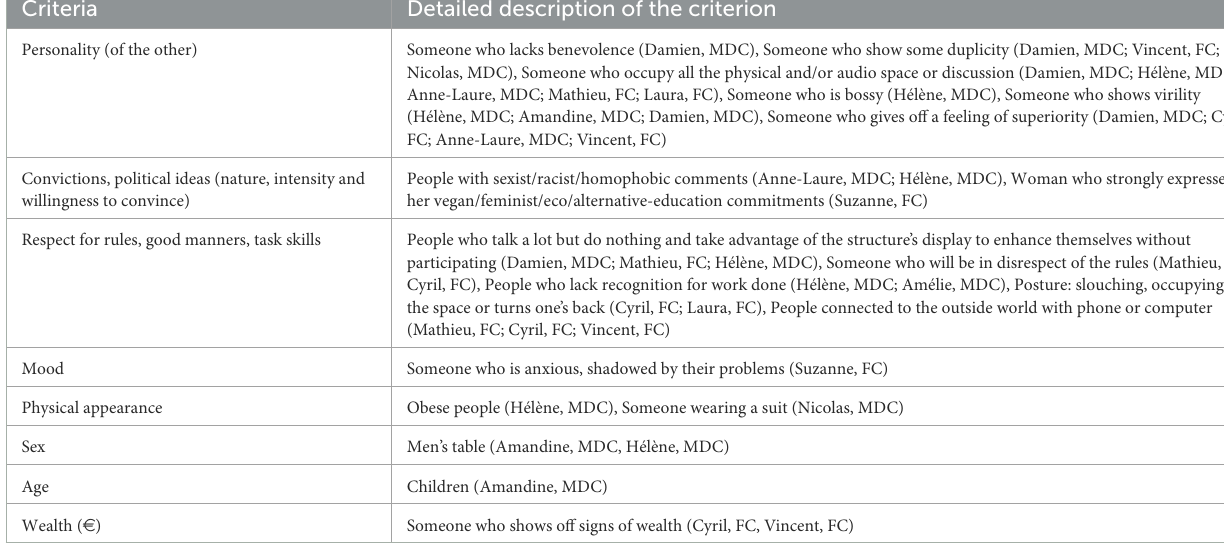
TABLE 2 Criteria describing people to whom respondents do not engage in care. Criteria Detailed description of the